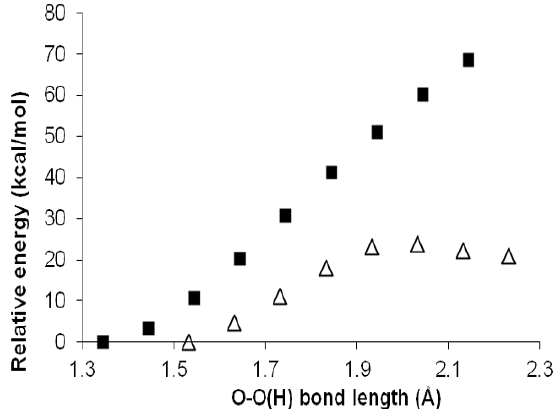
Figure 5. Relative energy depending on O-O bond length in models 2a (squares) and 6a